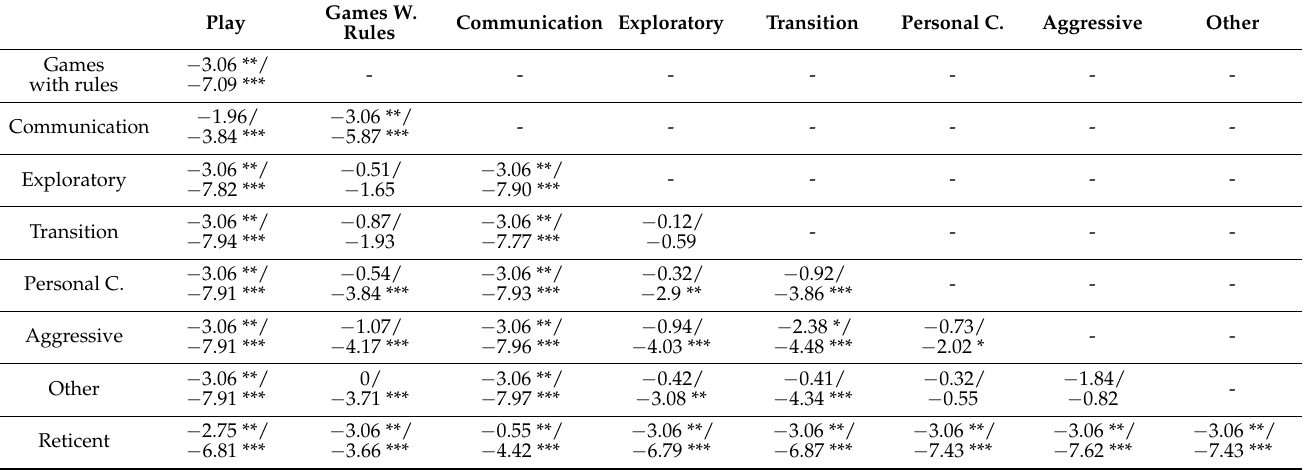
Table 2. Wilcoxon pairwise comparisons regarding types of activity DHH/TH